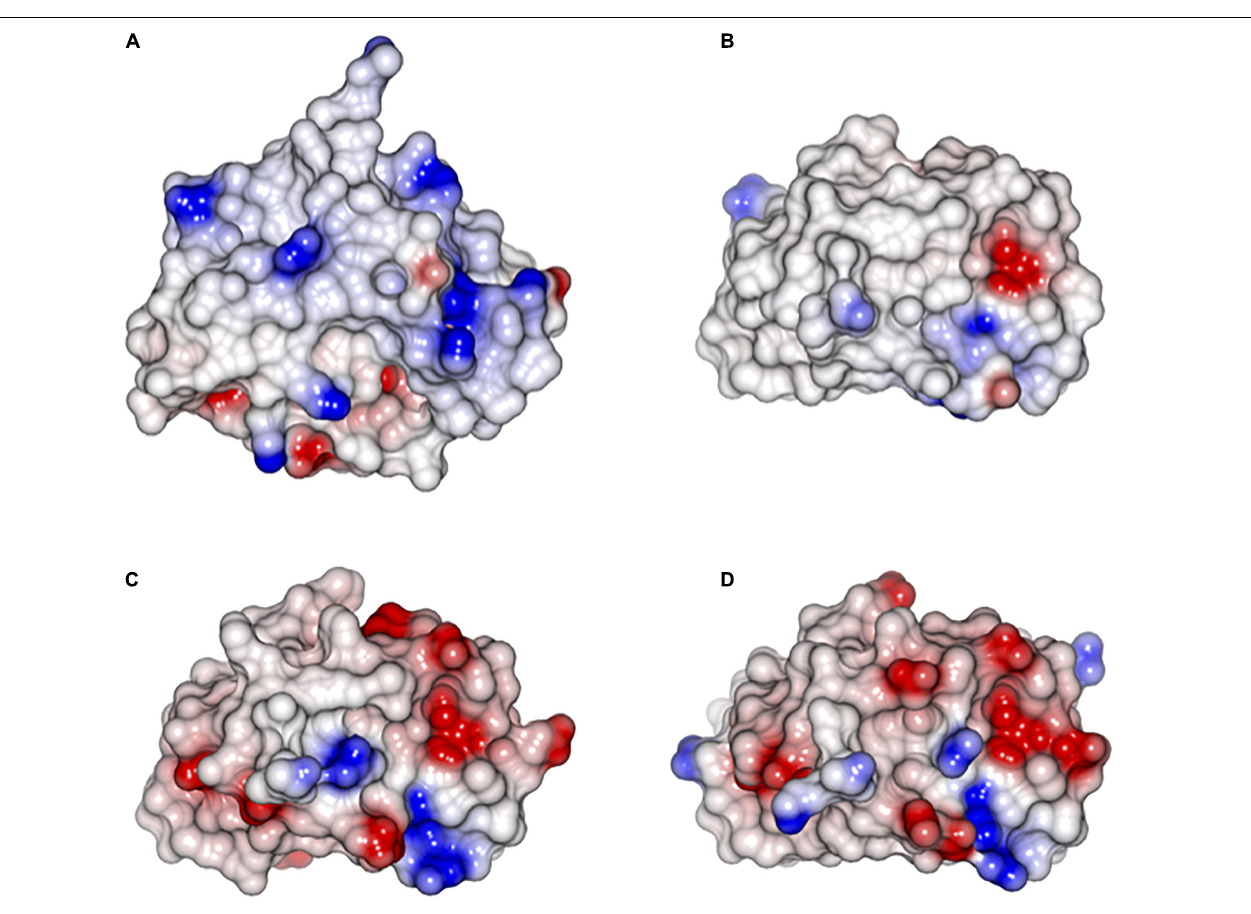
FIGURE 5 | Electrostatic surface of the SUGARWINs. (A) SUGARWIN1; (B) SUGARWIN2; (C) SUGARWIN3; (D) SUGARWIN4. SUGARWIN1 is more –positive (blue) than the remaining SUGARWINs. The electrostatic surface analysis shows a mainly electronegative surface in SUGARWIN 2, 3 and 4 suggestive of poor binding to RNA, if